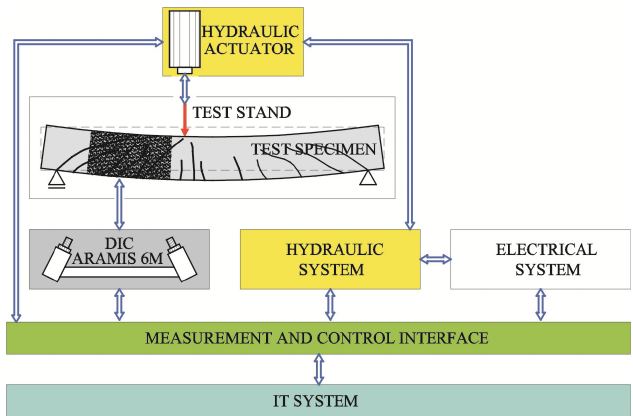
Figure 1. Block diagram of test stand.